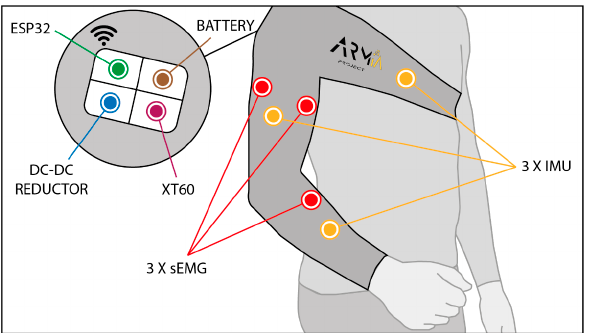
Figure 1. General appearance of the ARMIA wearable technology. A textile arm sleeve holds the inertial and sEMG sensors and is fastened to the chest for better fixation. The back of the wearable holds the battery and the microcontroller that communicates with the computer or device where serious games are running.